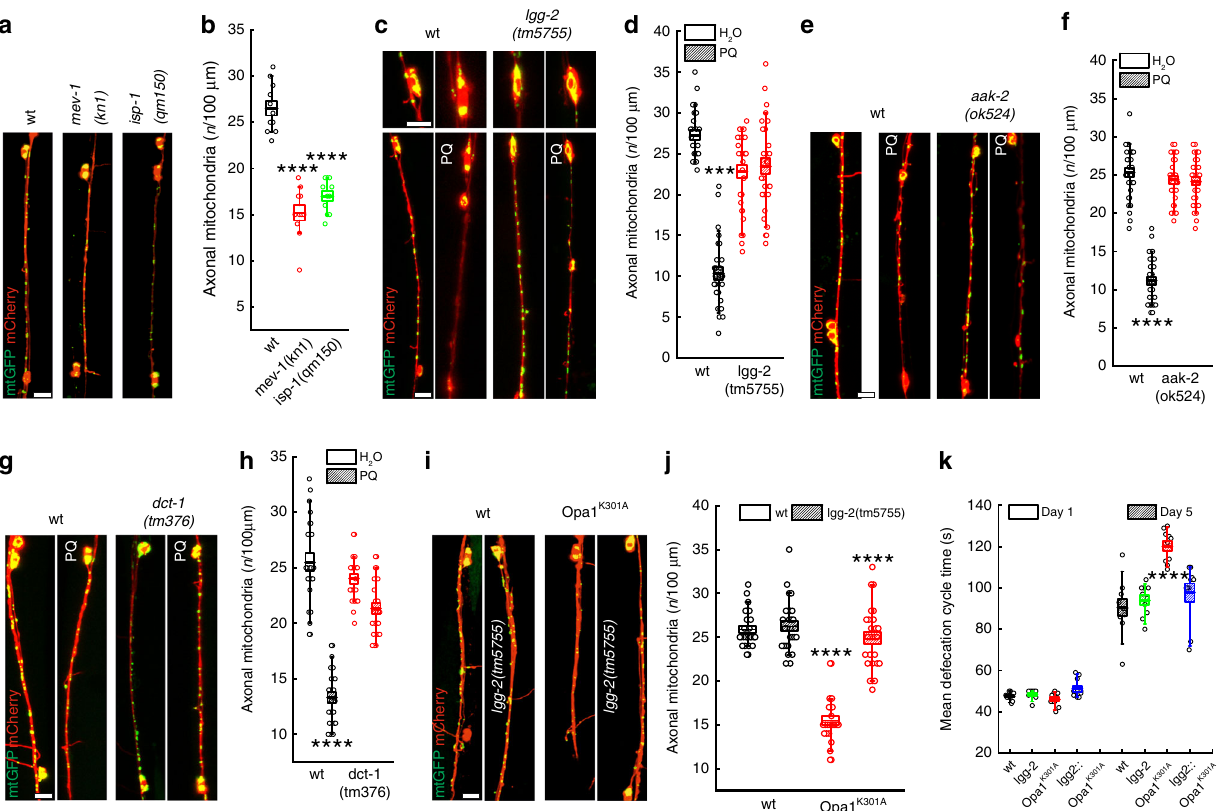
Fig. 4 Inhibition of autophagy restores mitochondrial content in axons of C. elegans carrying mitochondrial dysfunction. a Confocal images of mtGFP (green) and cytoplasmic mCherry (red) in GABA motor neurons of the indicated transgenic nematodes. Bar, 20 μ m. b Quanti fi cation of mitochondrial content in axons in n = 13 animals from three independent experiments as in ( a ). **** p < 0.0001 in one-way ANOVA/Tukey ’ s test. c Confocal images of mtGFP (green) and cytoplasmic mCherry (red) in GABA motor neurons of transgenic nematodes treated as indicated. Upper panels: magni fi ed soma region. PQ, paraquat. Bars, 20 μ m. d Quanti fi cation of mitochondrial content in axons in n = 25 animals from three independent experiments as in ( c ). ** p = 0.0012 in one-way ANOVA/Tukey ’ s test. e Confocal images of mtGFP (green) and cytoplasmic mCherry (red) in GABA motor neurons of transgenic nematodes treated as indicated. Bar, 20 μ m. f Quanti fi cation of mitochondrial content in axons in n = 25 animals from three independent experiments as in ( e ). **** p < 0.0001 in one-way ANOVA/Tukey ’ s test. g Confocal images of mtGFP (green) and cytoplasmic mCherry (red) in GABA motor neurons of transgenic nematodes treated as indicated. Bar, 20 μ m. h Quanti fi cation of mitochondrial content in axons in n = 25 animals from three independent experiments as in ( g ). **** p < 0.0001 in one-way ANOVA/Tukey ’ s test. i Confocal images of mtGFP (green) and cytoplasmic mCherry (red) in GABAergic motor neurons of the indicated transgenic nematodes expressing Opa1 K301A . Bar, 20 μ m. j Quanti fi cation of mitochondrial content in axons in n = 25 animals from three independent experiments as in ( i ). **** p < 0.0001 in one-way ANOVA/Tukey ’ s test. k Quanti fi cation of defecation motor program duration recorded in n = 10 transgenic nematodes from three independent experiments at the indicated days of life. **** p < 0.0001 in one-way ANOVA/ Tukey test. In box plots, centre line represents mean, bounds of boxes SEM, whiskers the 10th – 90th percentiles; each dot represents an individual nematode form the indicated N of independent experiments. Source data are provided as a Source Data fi Opa1 Δ RGC/ Δ RGC :: Atg7 Δ RGC/ + cells (Fig. 5g). This autophagy